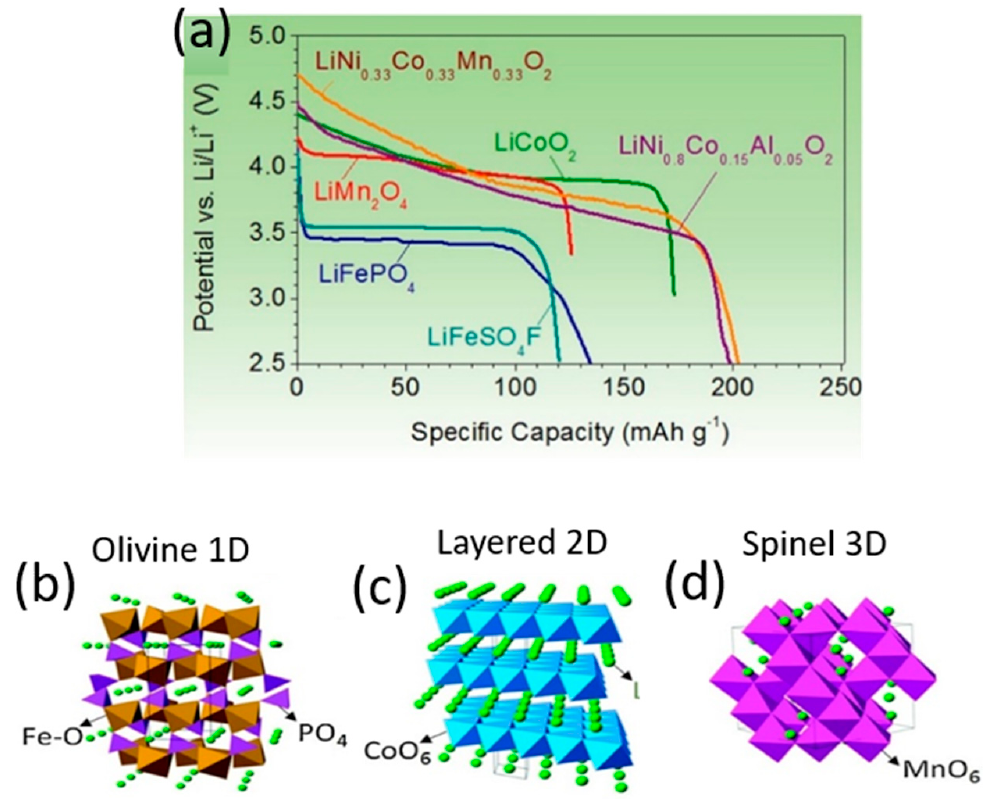
Figure 2. Discharge profiles ( a ) and crystal structures ( b – d ) of representative intercalation cathodes: olivine LiFePO 4 ( b ), layered LiCoO 2 ( c ) and spinel LiMn 2 O 4 ( d ). Out of the three classes of oxide cathodes, layered oxides are the preferred option.